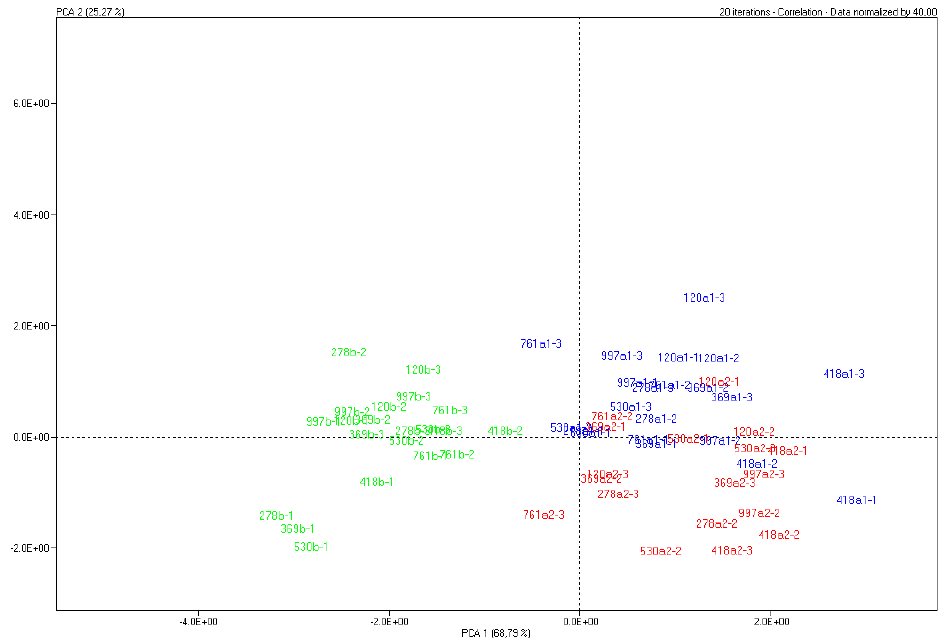
Figure 1. Score plot of artisanal pecorino-style hard cheese of pieces of 250 and 500 g ( n = 24) at 0.0 − kGy and 5.0 − kGy irradiation treatment. Green = Samples “0.0 kGy”; Red (a2) = 5.0 kGy, 250 g; Blue (a1) = 5.0 kGy, 500 g.